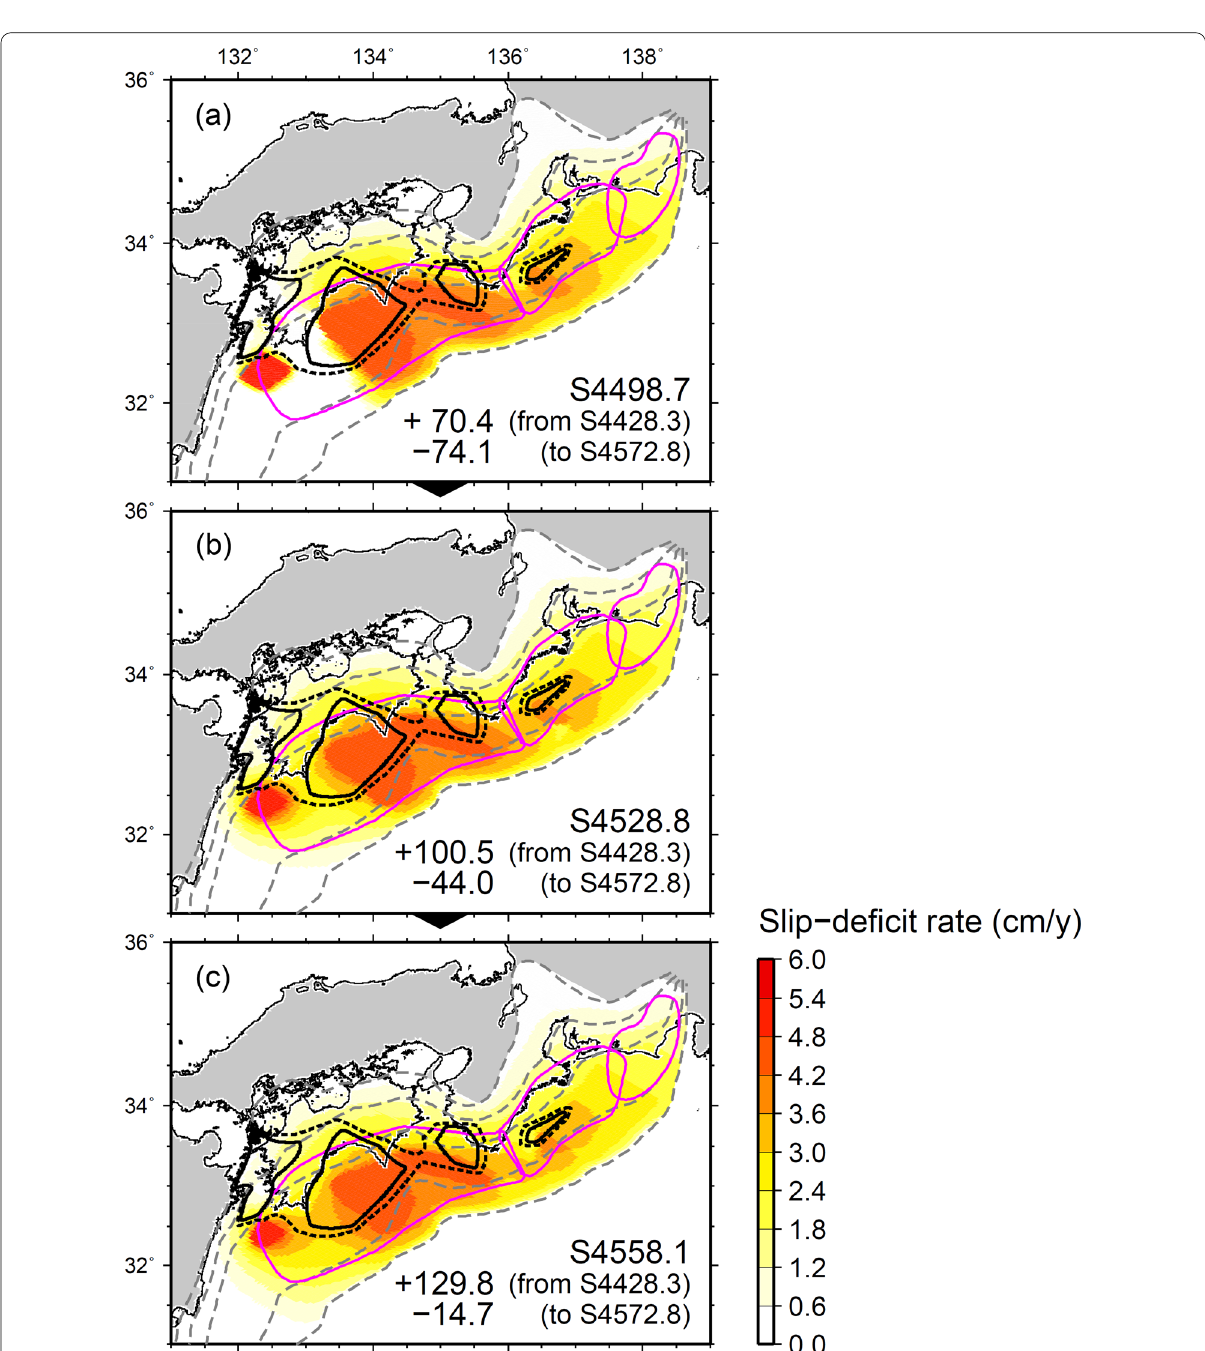
(Nishimura et al. 2018). Numbers at lower right indicate the elapsed time from the start of the simulation, the elapsed time from the